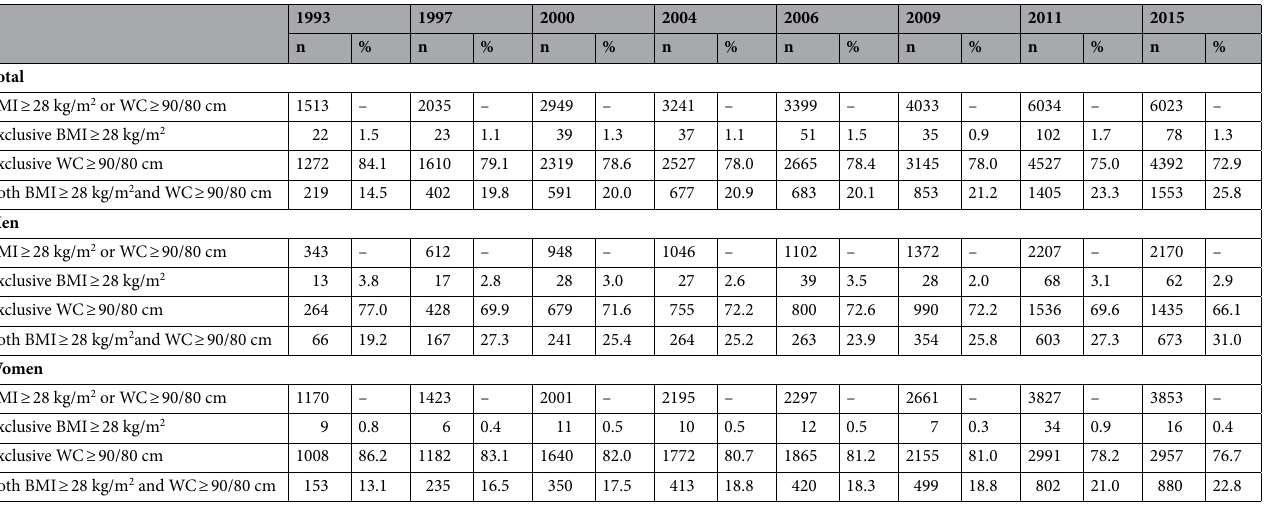
Table 4. Overlap between body mass index (≥ 28 kg/m 2 )- and waist circumference-based obesity among Chinese adults. Proportions of obesity based on both WC ≥ 90/80 cm and BMI ≥ 28 kg/m 2 (overlap between BMI- and WC-based obesity) is calculated as the number of obesity based on both WC ≥ 90/80 cm and BMI ≥ 28 kg/m 2 divided by the number of obesity based on either WC ≥ 90/80 cm or BMI ≥ 28 kg/m 2 . Likewise, proportions of exclusive general obesity and exclusive central obesity are calculated by the similar